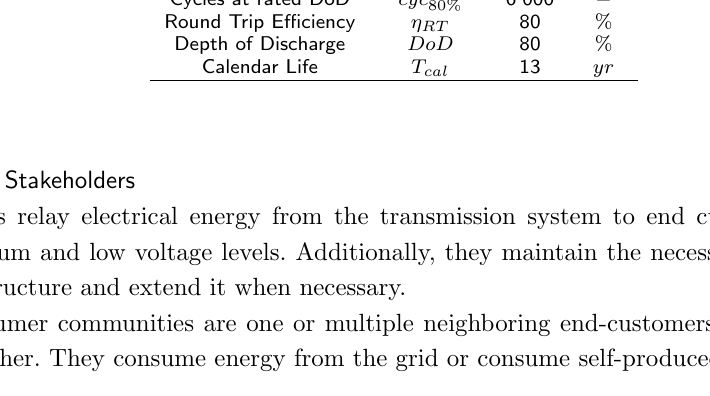
the Prosumer and the DSO bene(cid:12)t with a "Prosumer only optimization". The solid lines represent a "combined optimization". With such a setup the overall bene(cid:12)t